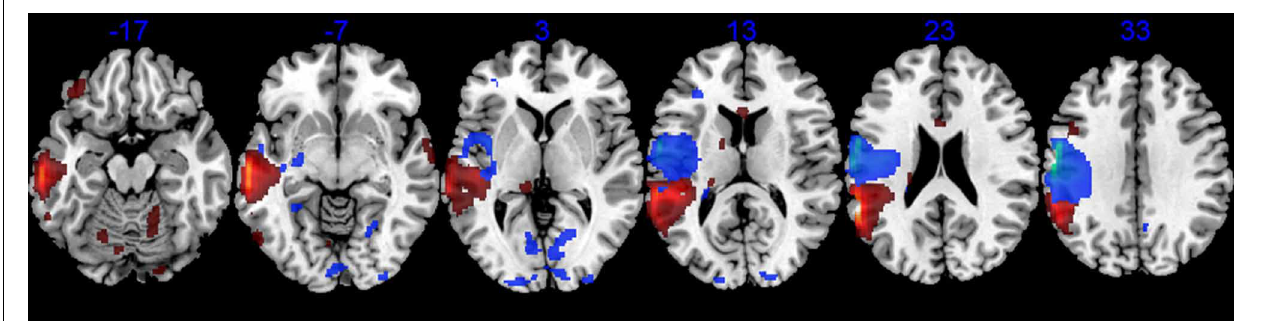
FIGURE 6 | 18 FDG-PET. Axial PET images (MRIcroN) of patients with transcortical motor aphasia (blue) and conduction aphasia (red) showing significant reductions of metabolic activity in the left perisylvian areas and interconnected areas (see Table 4 ). Note that although the structural